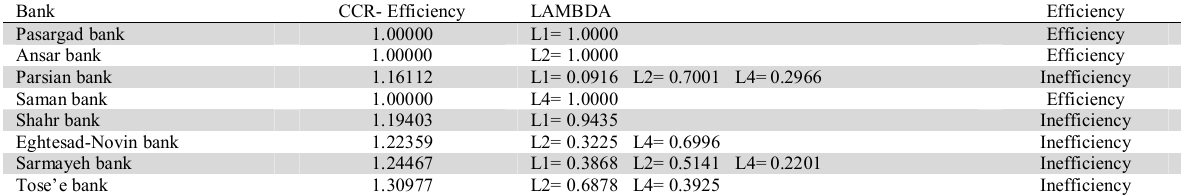
Efficiency values associated with customer satisfaction index, Output-orientated CCR model Bank